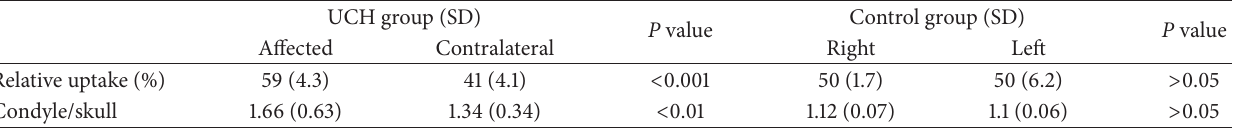
Table 2: Quantitative analysis of the ROI in patients with UCH and controls.